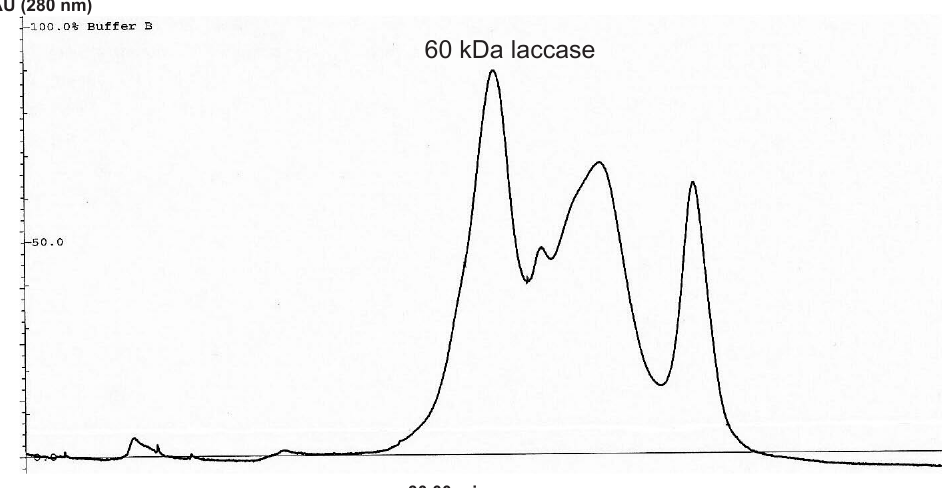
Figure 2. Purification profile of the laccase isolated from Fomitiporia mediterranea with sodium phosphate buffer 50 mM pH7 and 15 M